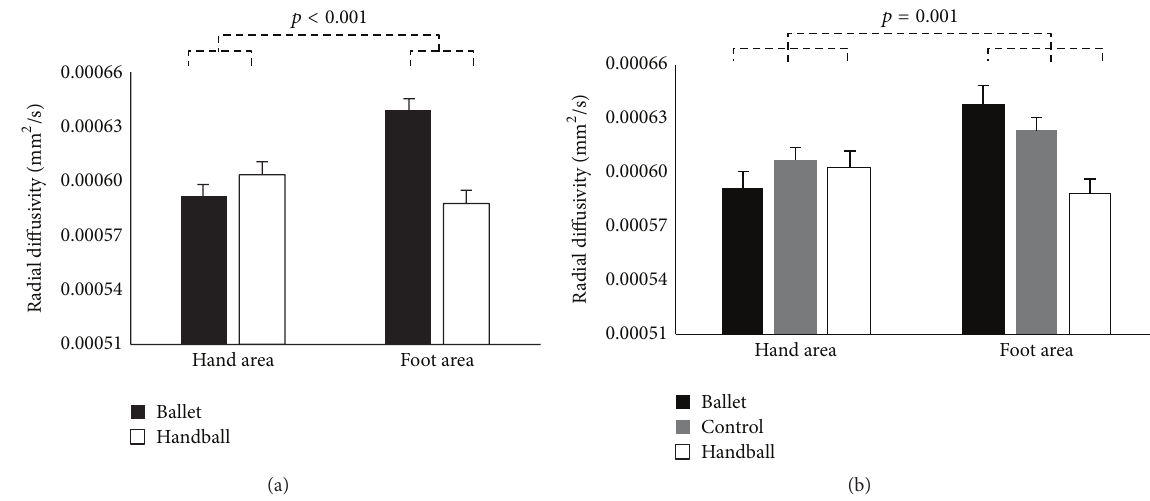
Figure 4: Estimated means and standard errors of radial diffusivity (RD) in the corticospinal tracts originating in the hand and foot areas (independent of hemisphere and modality) for the ballet dancers ( 𝑛 = 10 ) and the handball players ( 𝑛 = 12 ) depicted on (a) (rmMANOVA including only the sports groups) and for the ballet dancers ( 𝑛 = 10 ), the handball players ( 𝑛 = 12 ) and the control women ( 𝑛 = 22 ) depicted on (b) (rmMANOVA including all three groups). Note that increased RD reflects sport-specific